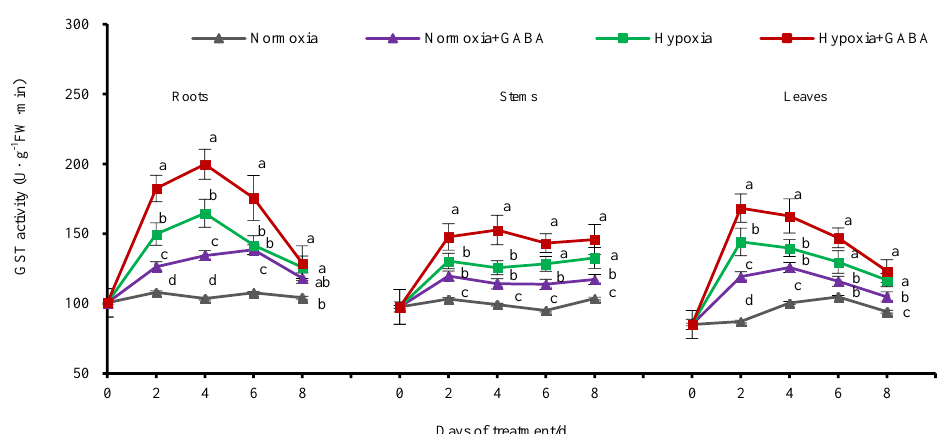
Figure 5. Effects of exogenous GABA on GST activity in the roots, stems, and leaves of melon seedlings under root hypoxic stress for 0, 2, 4, 6, and 8 d. Different letters a–d indicate significant difference ( p < 0.05).